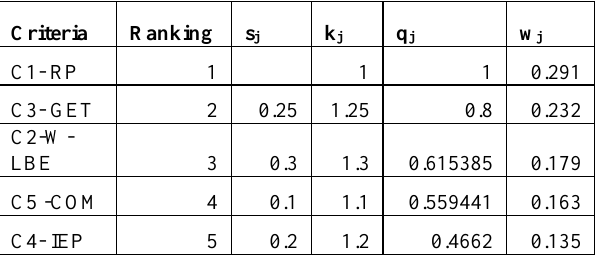
Table 3: SWARA Weighting Results for DM 1 Criteria